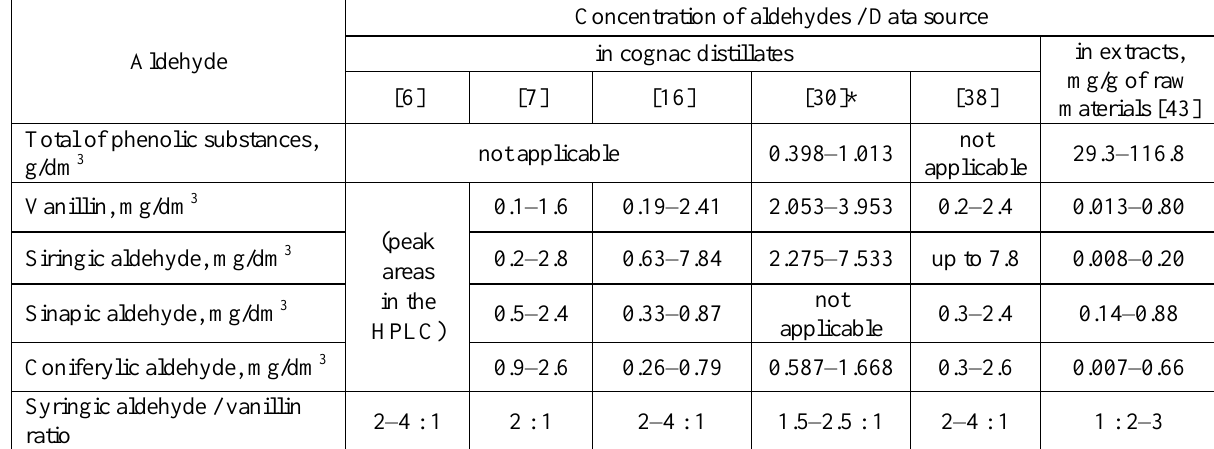
Table 1. Content of phenolic substances and aromatic aldehydes in the aqueous-alcoholic extractsof oak wood and the cognac distillates of different ageing periods (the ageing from 2.5 to 15 years) Concentration of aldehydes / Data source in cognac distillates Aldehyde